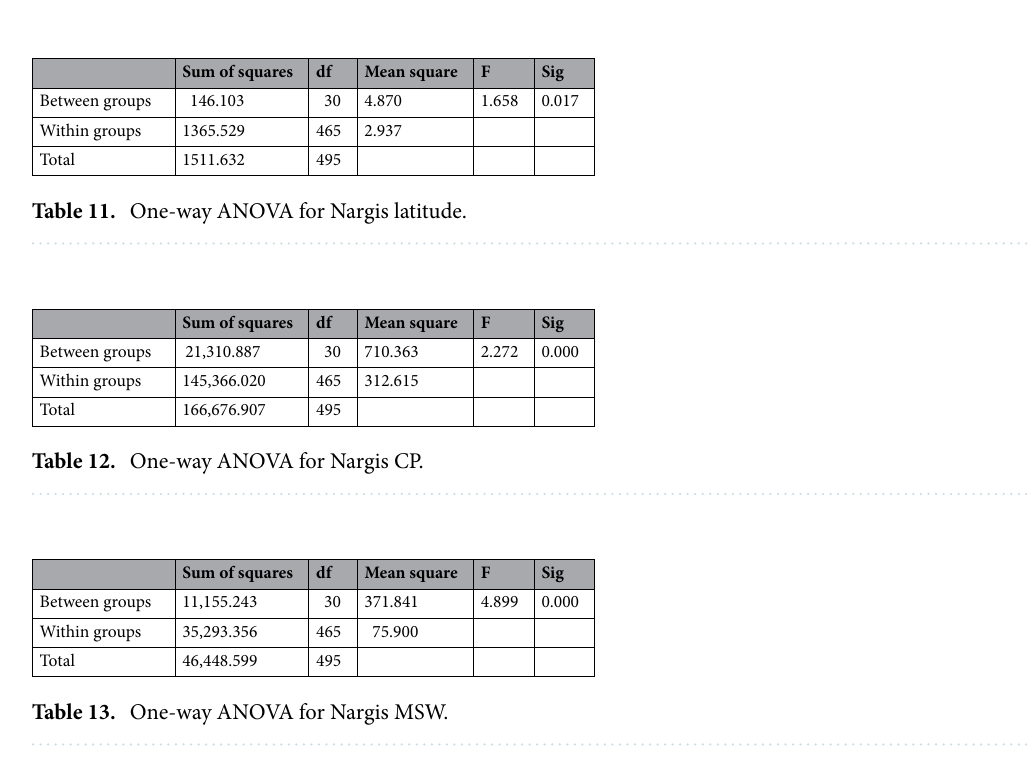
Table 10. One-way ANOVA for Nargis Longitude.